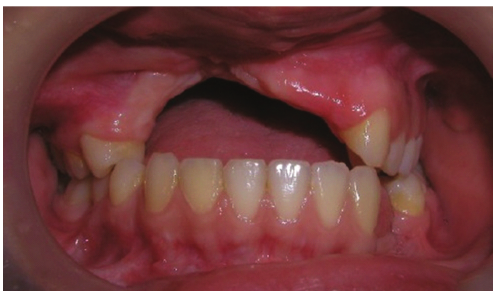
Figure 3: Intraoral view of patient before treatment, with missing maxillary and mandibular teeth and alveolar anterior